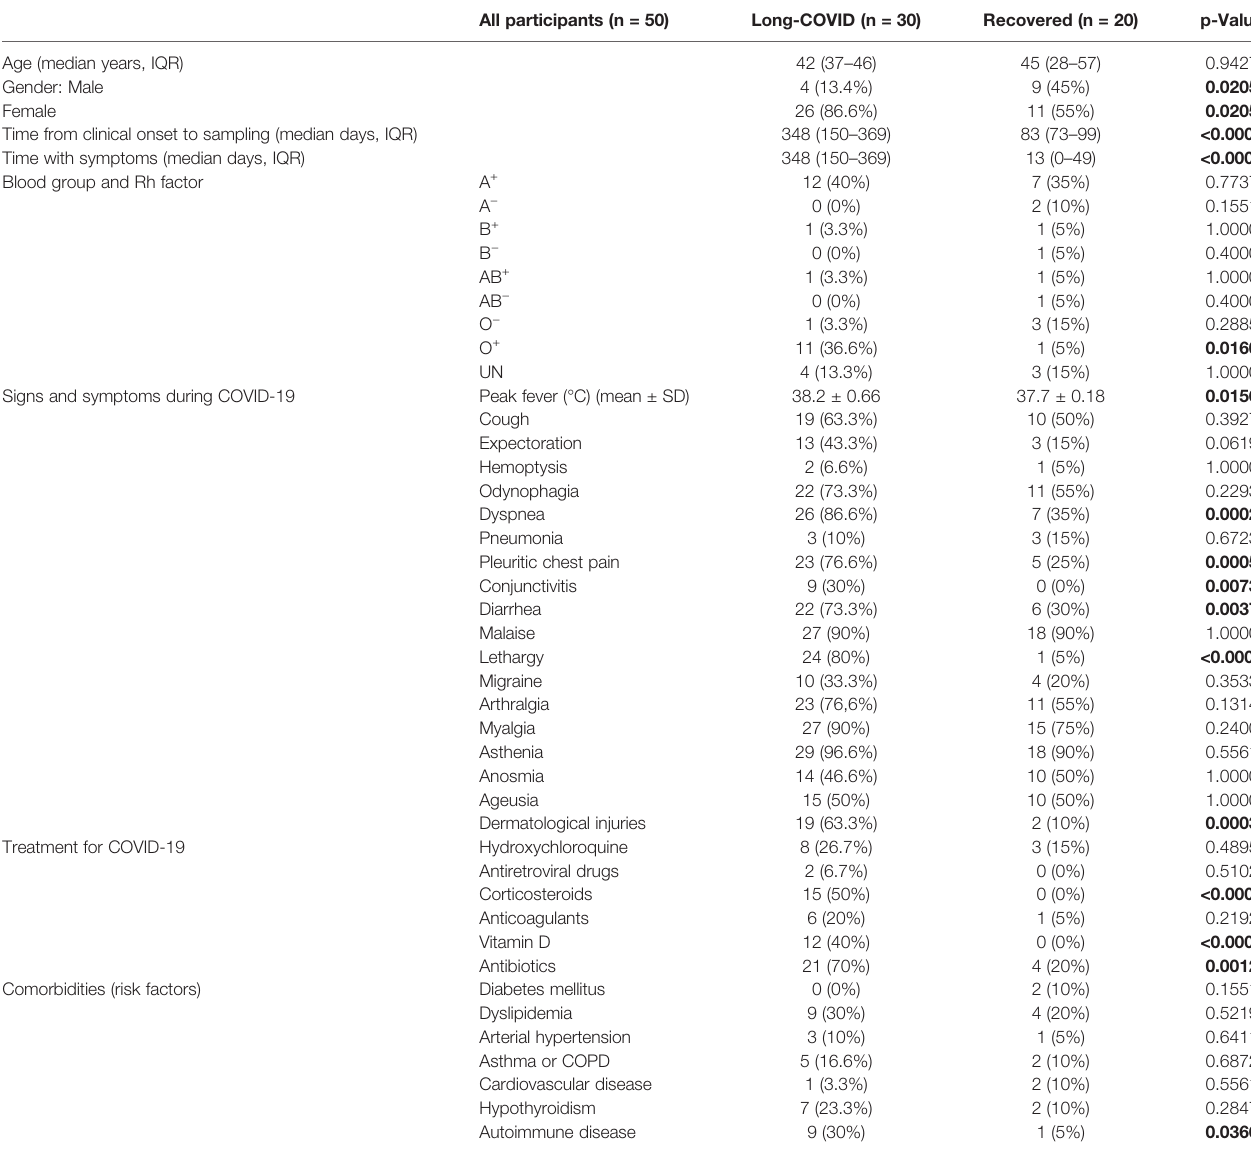
TABLE 1 | Demographic and clinical data of all participants from the Long-COVID group and the Recovered group that were recruited for this study. All participants (n =